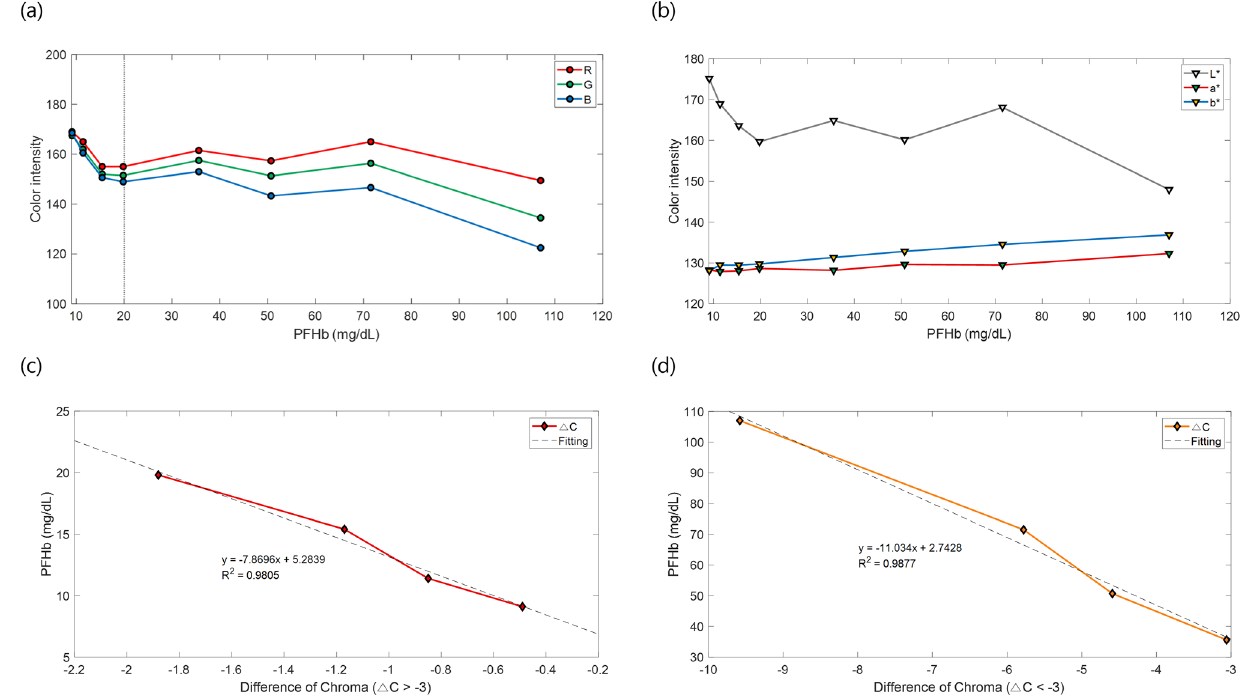
Figure 3. Standard curves of the PFHb levels . ( a ) Intensities of the RGB color channels according to PFHb levels. ( b ) Intensities of the L.a.b. color spaces converted from RGB. ( c , d ) Standard curves as measured by the proposed device. ( c ) Calibration curve in a region where the saturation difference (∆C) is greater than − 3, and ( d ) calibration curve in a region where the ∆C is less than −